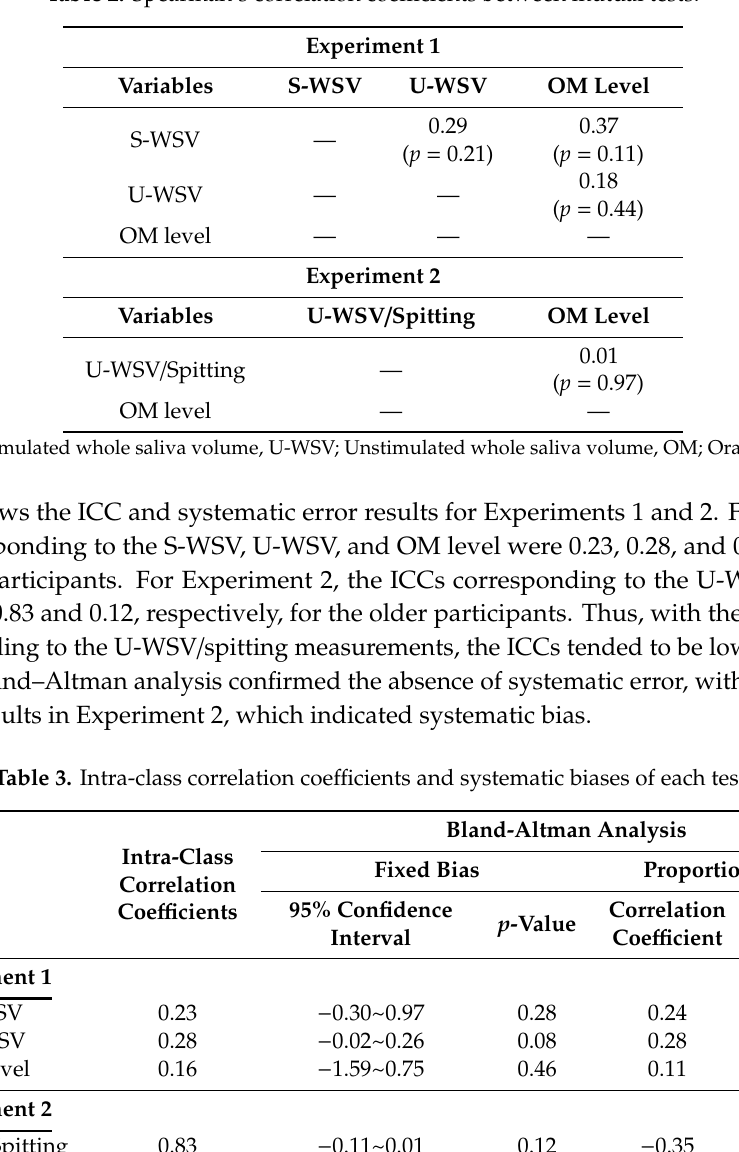
Table 2. Spearman’s correlation coe ffi cients between mutual tests.